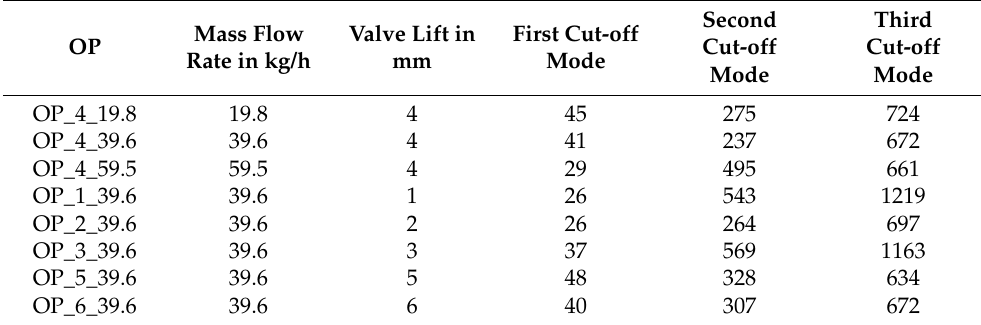
Table 3. Three cut-off modes of the POD quadruple decomposition for all the operating points measured using PIV.